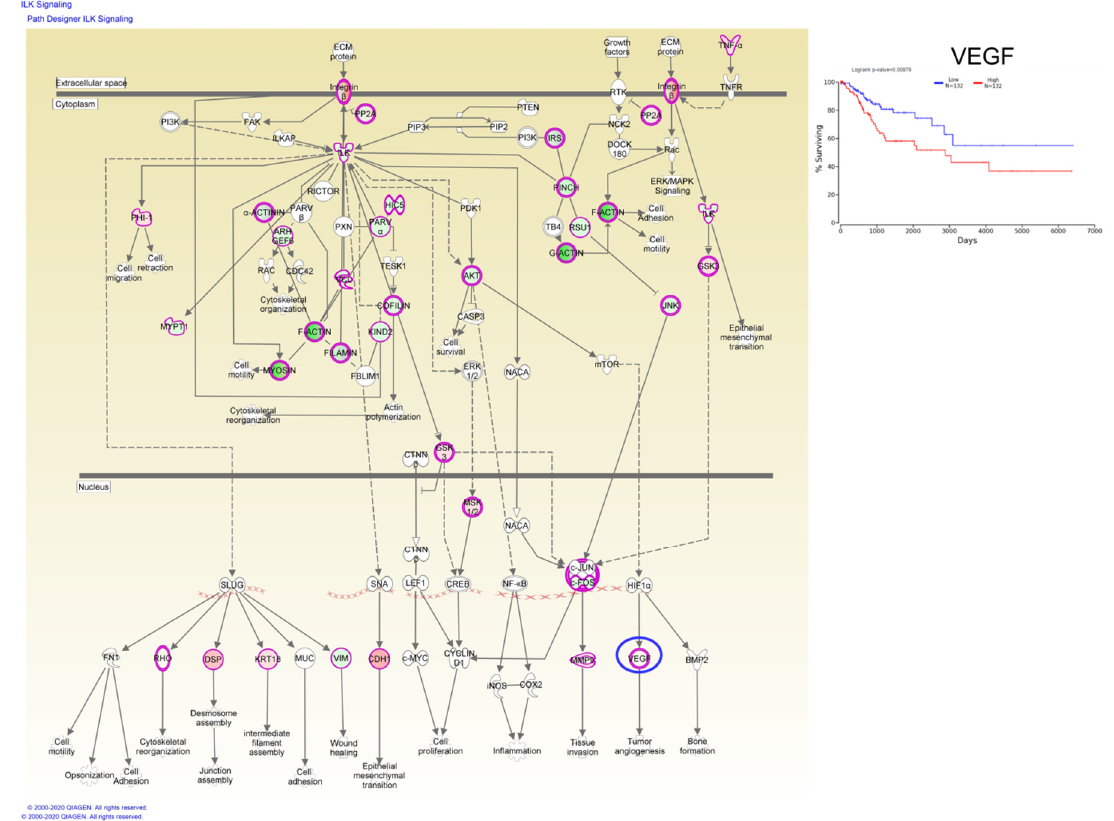
Figure 7. ILK signaling based on altered genes in CC, wherein the VEGF gene predicts the overall survival rate; red: overexpressed genes, green: downregulated genes, blue circles are for genes predicting overall survial rate in CC